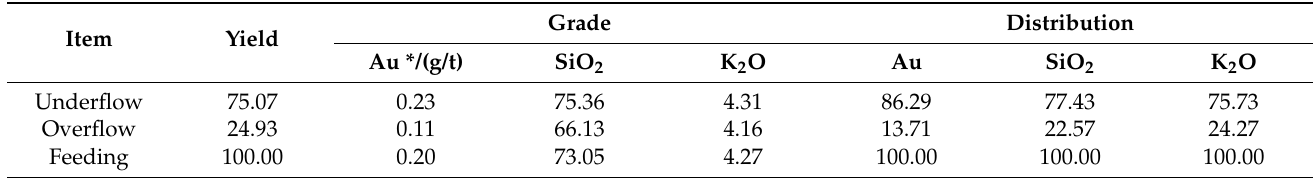
Table 5. Desliming results (mass fraction,